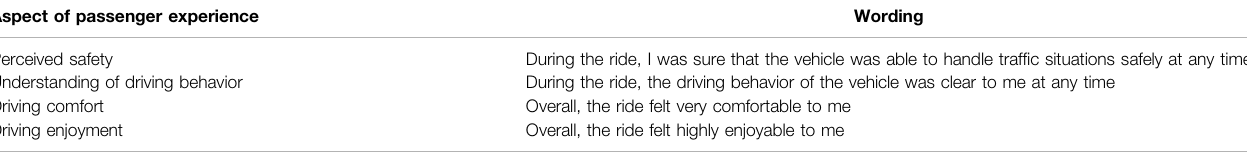
TABLE 2 | Wording of the single items used for the assessment of passenger